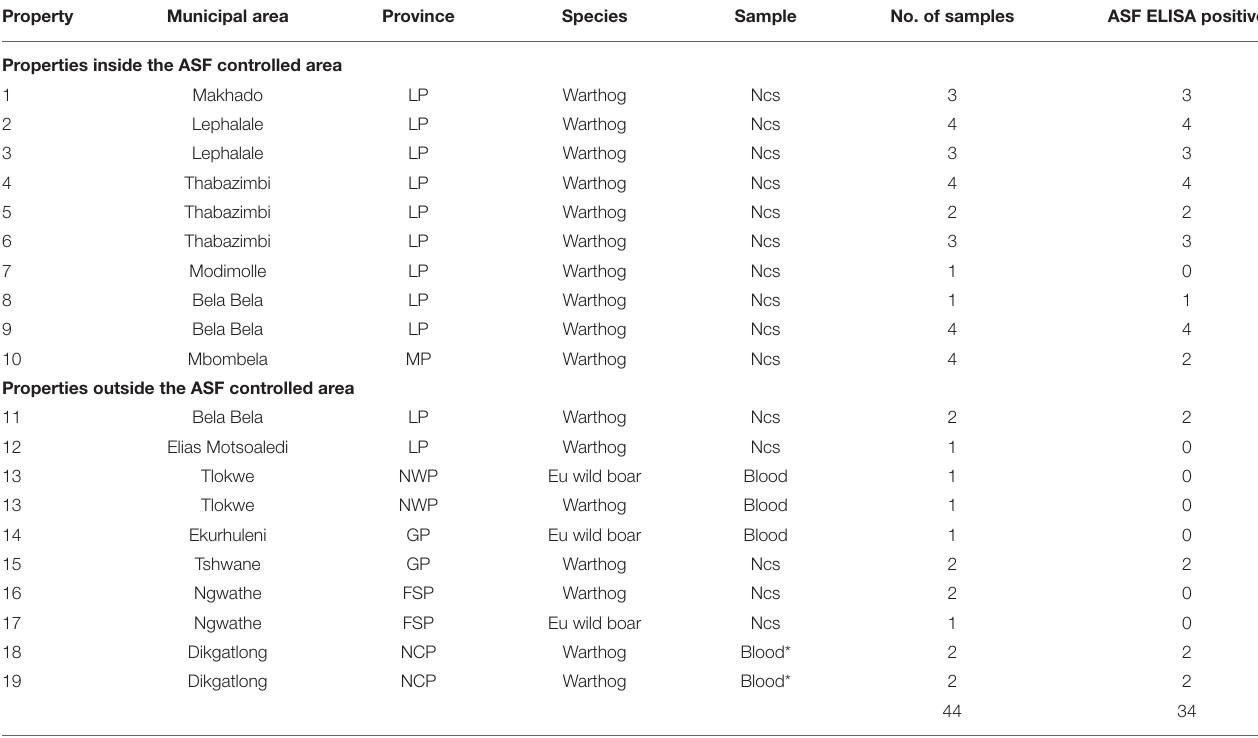
TABLE 2 | Dried blood samples on Nobuto cellulose strips (Ncs) and clotted blood samples from warthogs or Eurasian wild boars received from hunters or landowners from 10 properties inside and 9 outside the African swine fever controlled area in South Africa during 2019 and 2020 (abbreviations as given in the text).